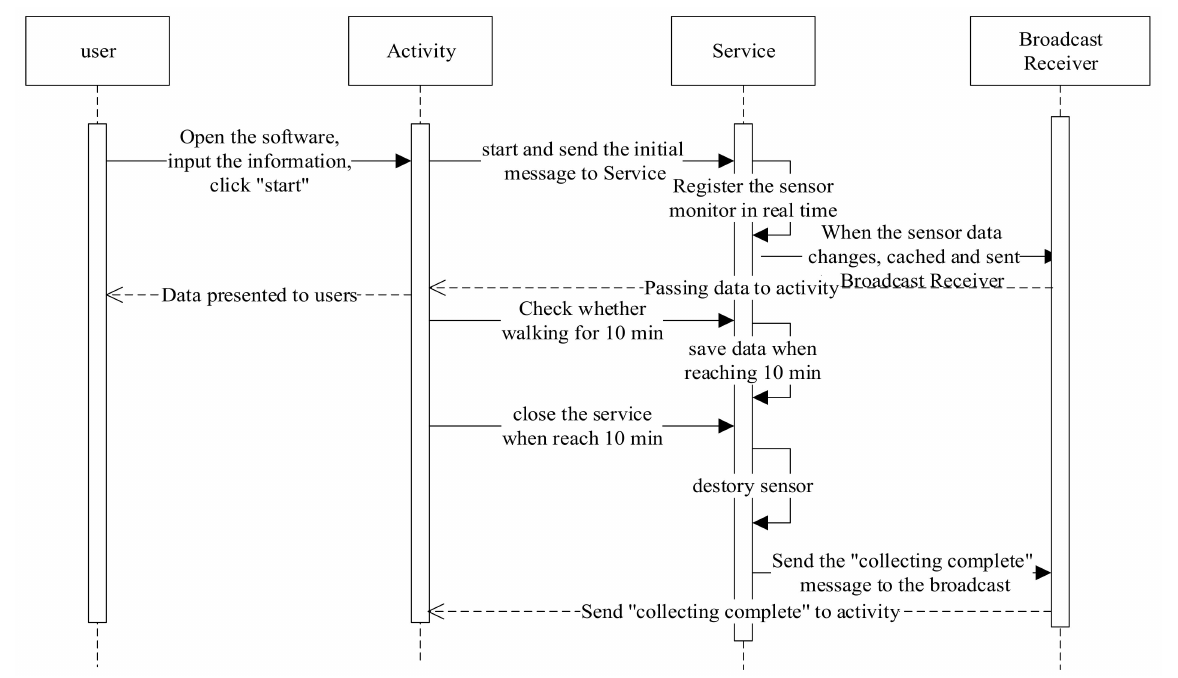
Figure 1. The background interaction process of the acquisition